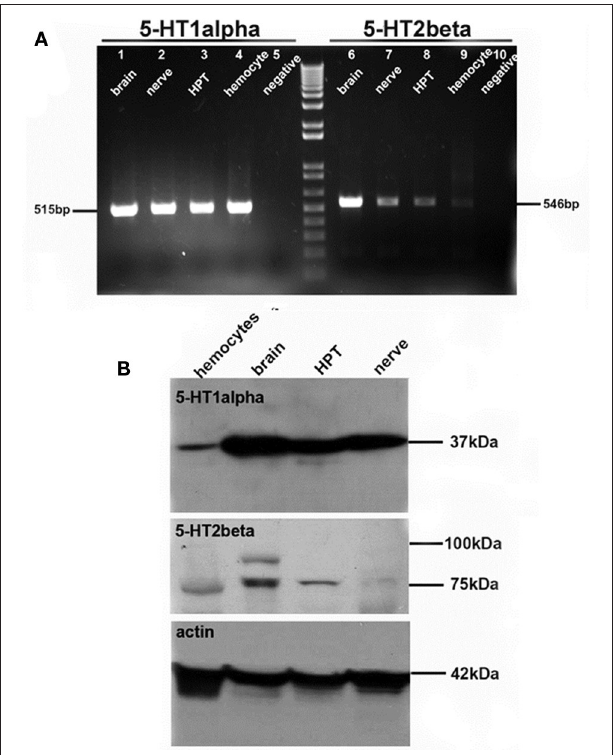
FIGURE 9 | Serotonin receptor subtypes are expressed in hemocytes and brain. (A) RT-PCR reveals the expression of 5-HT1 α (left) and 5-HT2 β (right) receptor subtype mRNAs in brain (lanes 1, 6), nerve (lanes 2, 7), hematopoietic tissue (HPT, lanes 3, 8), hemocytes (lanes 4, 9) and the negative control (lanes 5, 10). (B) Western blot for 5-HT1 α (top) and 5-HT2 β (middle) receptor proteins, with actin control (bottom). Adapted from Benton et al.